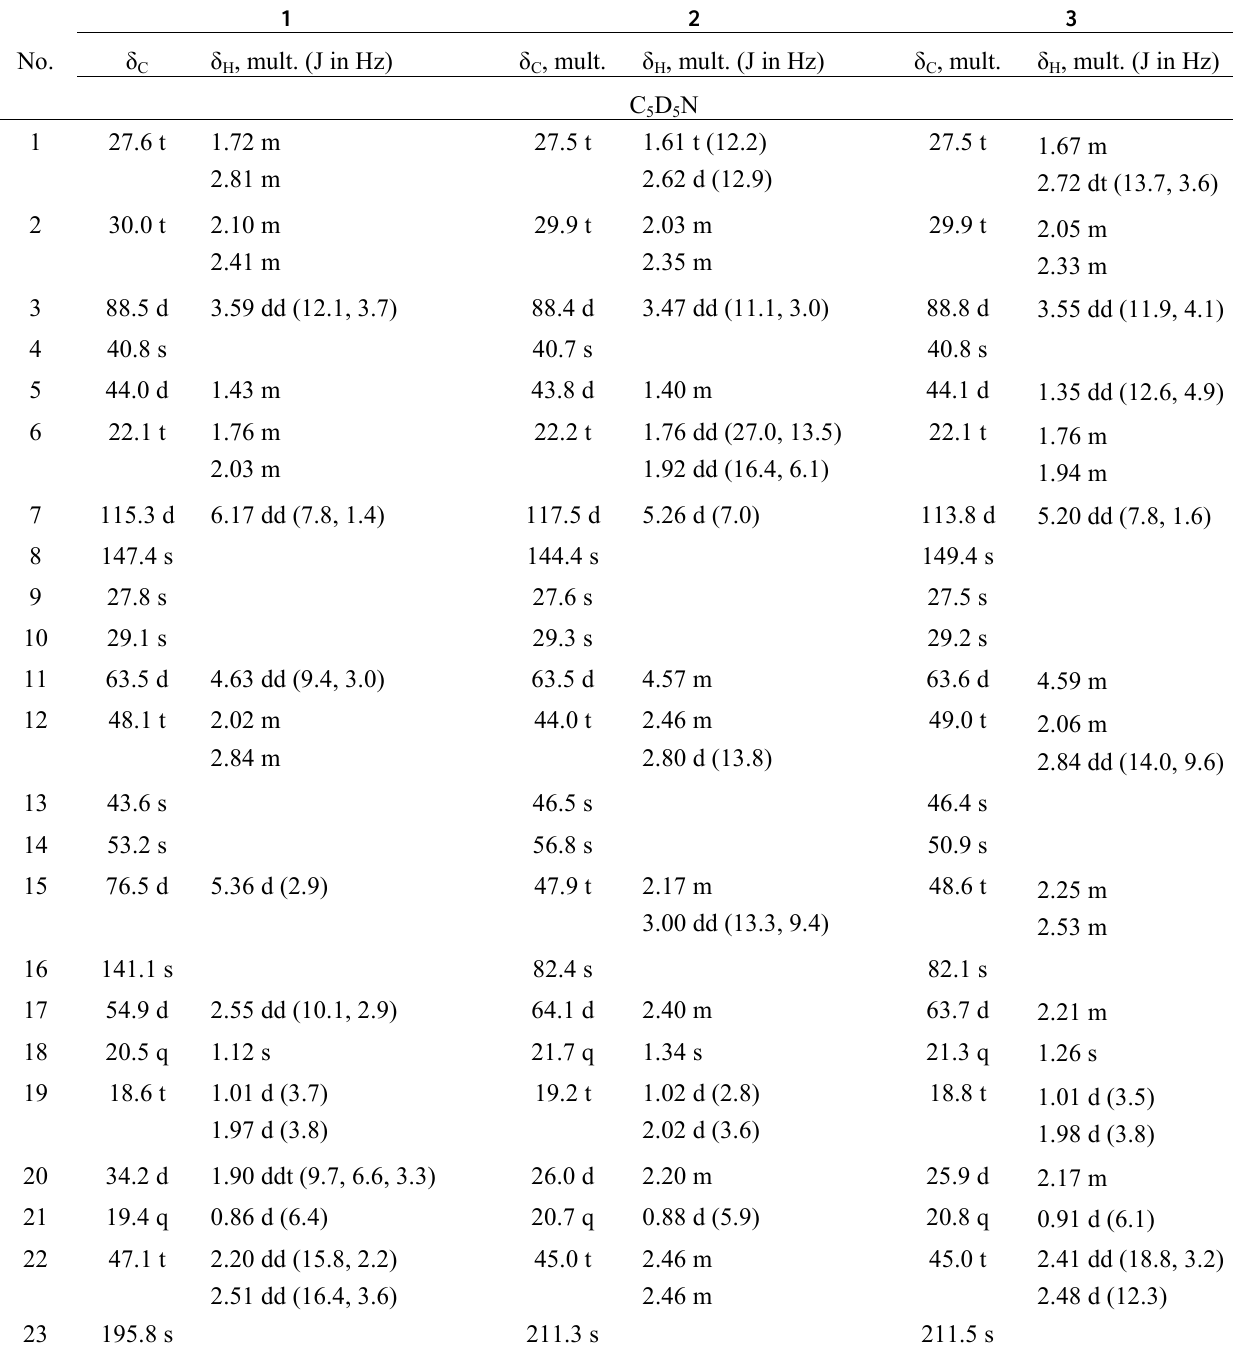
Table 1. 1 H- and 13 C-NMR Data for Compounds 1, 2 and